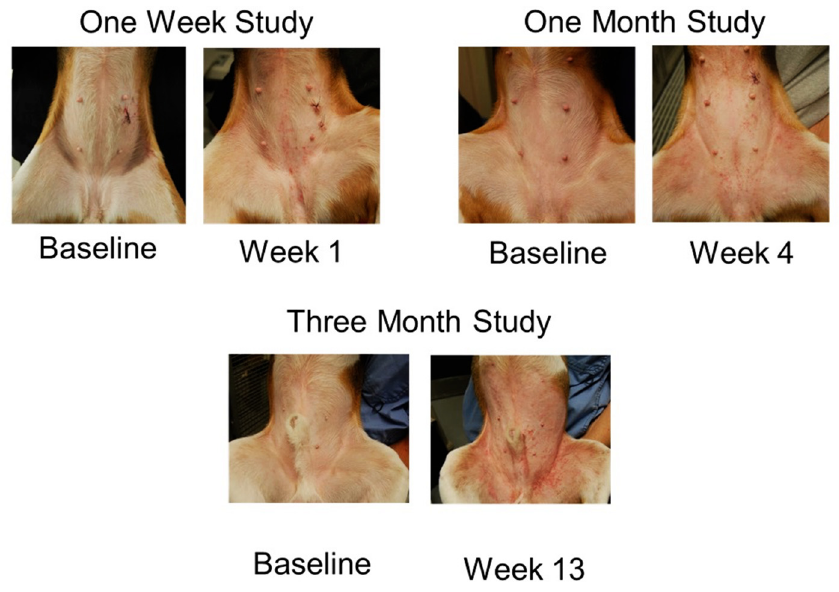
Figure 3. Examples of dogs’ presentations at baseline (prior to any allergen challenge) and at the end of the allergen challenges.